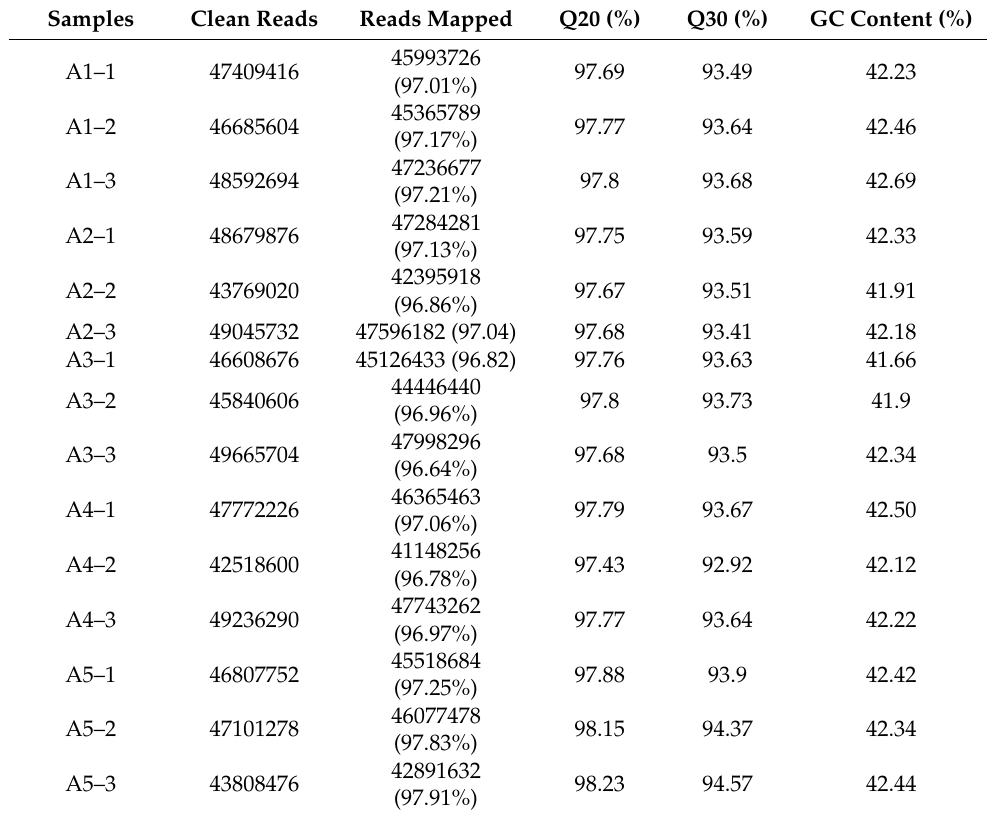
Table 1. Overview of the transcriptome sequencing data and quality check.